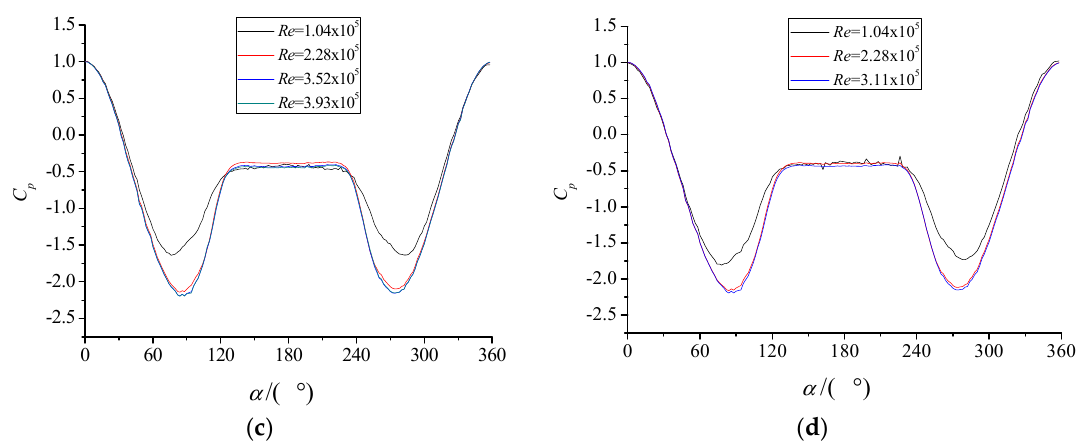
Figure 14 . Wind pressure distribution in different flow. ( a ) I u = 0%; ( b ) I u = 4%; ( c ) I u = 8%; ( d ) I u = 12%.